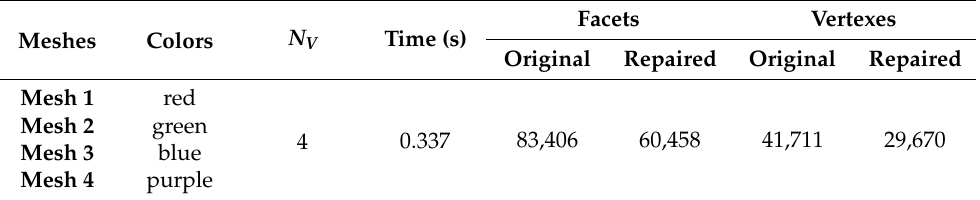
Table 4. Parameters of the multi-labeled mesh with input five sub-meshes. N V is the number of voids, the Time is the time consumed in repairing the mesh, the Facets is the number of the triangular facets in multi-labeled mesh, the Vertexes is the number of mesh vertexes in multi-labeled mesh.